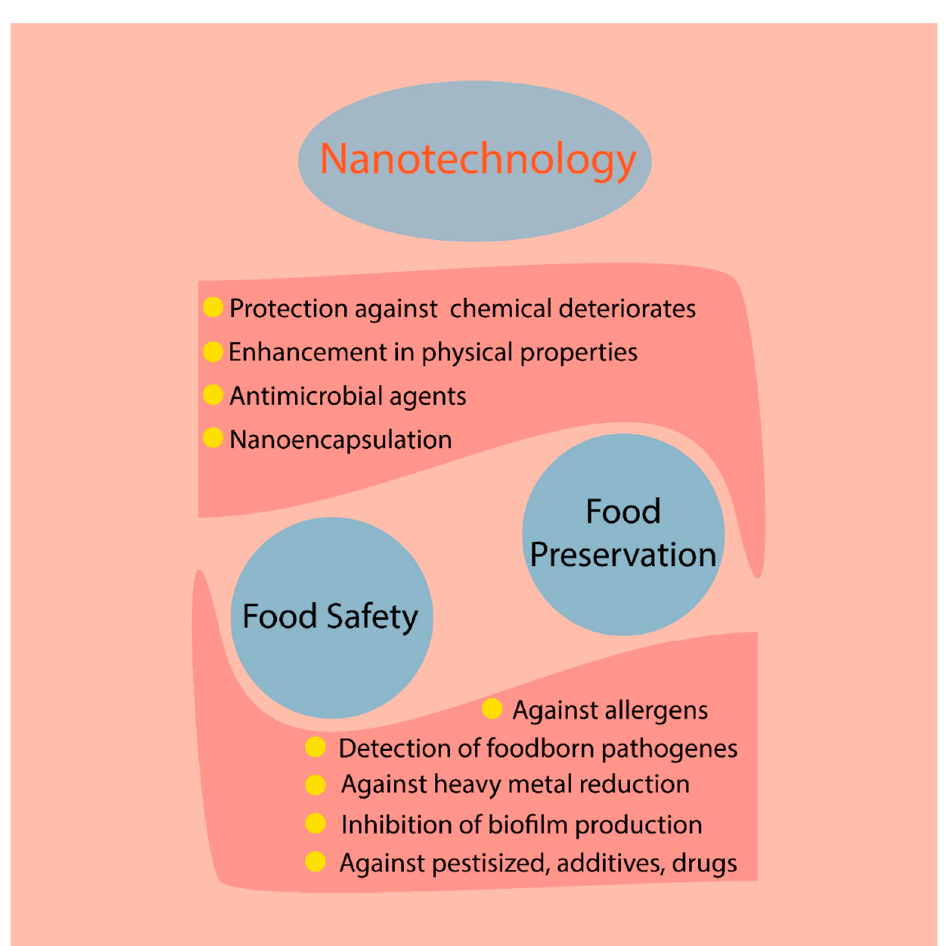
Figure 1. A schematic presentation of nanotechnology applications in daily life.